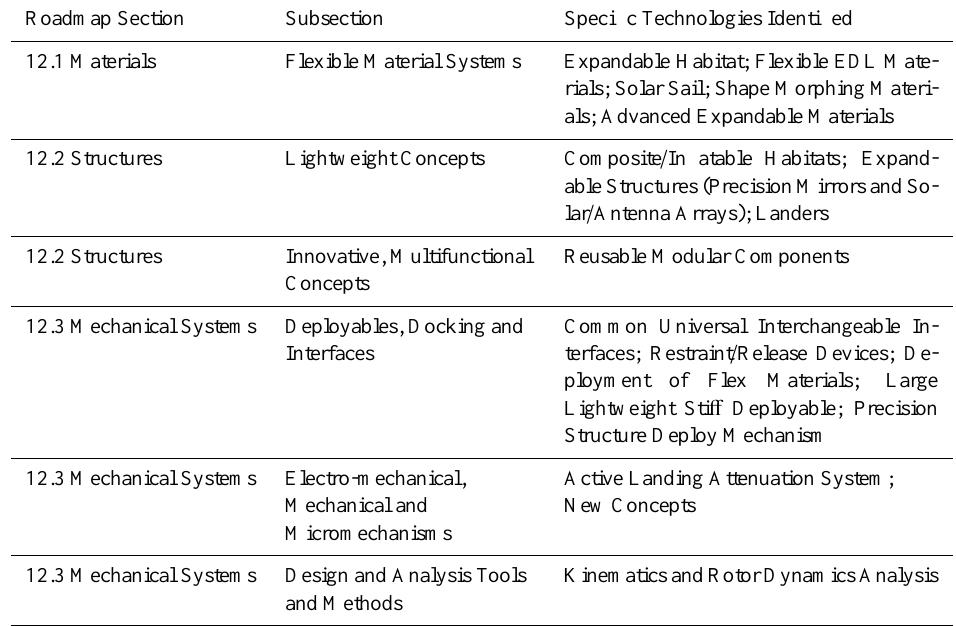
Table 2. Technologies Identified for Future Development by NASA Technology Roadmap 12 (Piascik et al.,